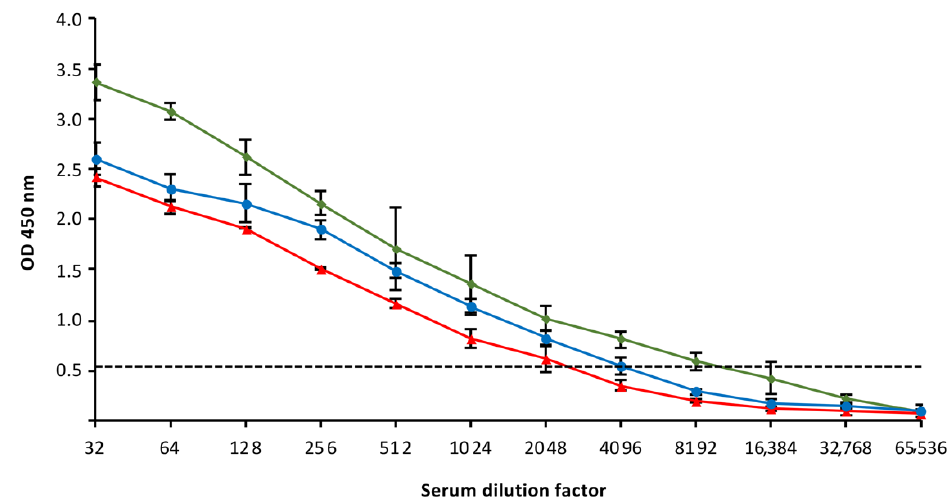
Figure 11. ELISA detection of specific anti-MCP antibodies in gilthead seabream sera collected one (green), two (blue) and three (red) months post-vaccination. Data are expressed as mean ± SD (n = 5). The positive threshold is represented by a dotted line.